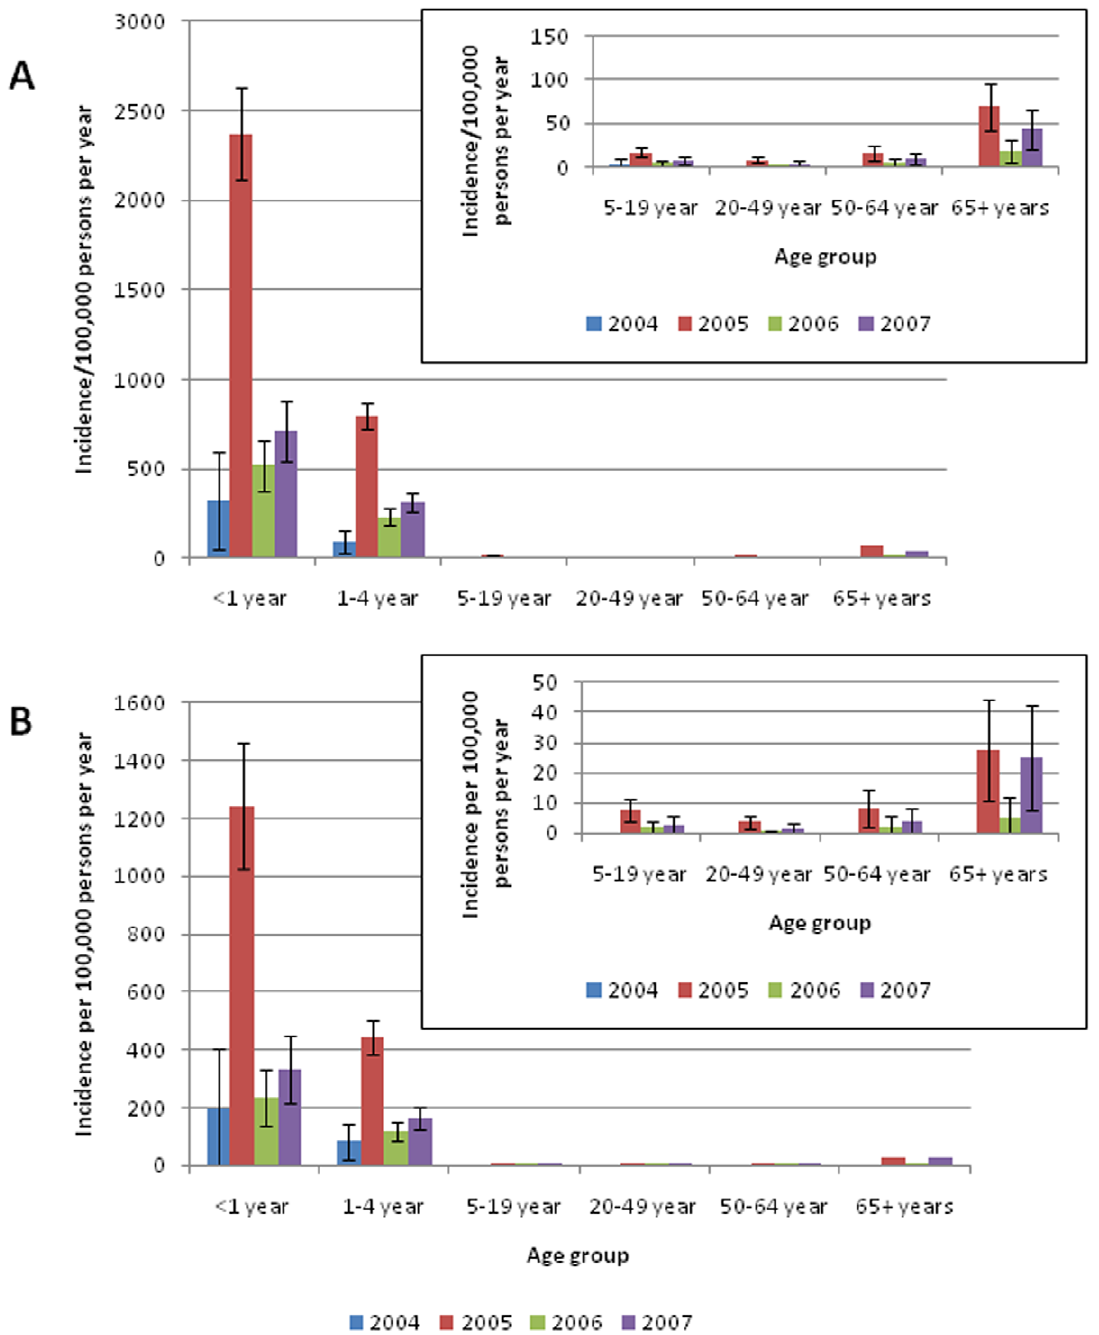
Figure 1. Adjusted annual incidence of hospitalized RSV respiratory illness (A) and hospitalized chest radiograph-confirmed RSV pneumonia (B) by age group, SaKaeo and Nakhon Phanom Provinces, during four consecutive years, January 1, 2004 – December 31, 2007. 2004 data are only from Sa Kaeo Province. Inset shows adjusted incidence values for age groups, 5–19 years, 20–49 years, 50–64 years, and $ 65 years.